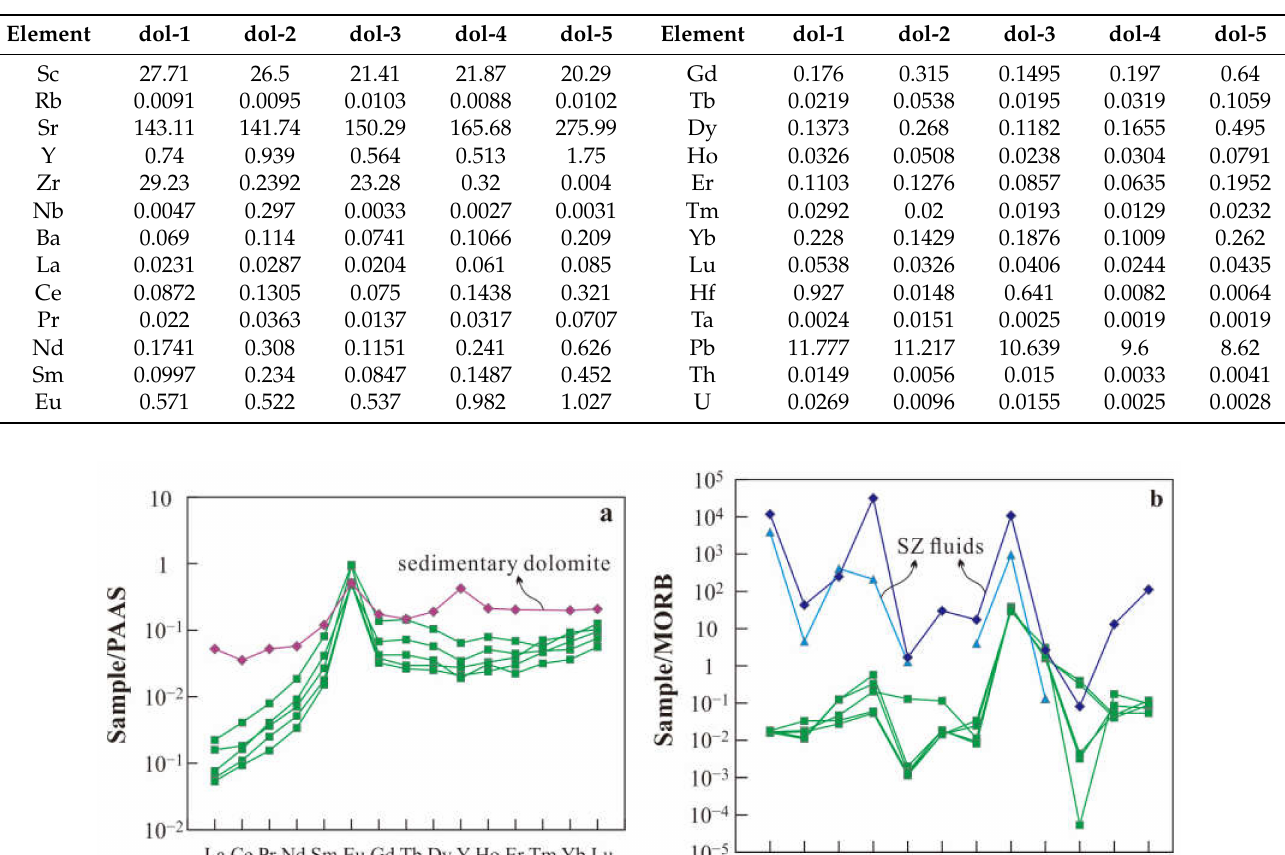
Table 1. Trace elements concentrations (ppm) of dolomite from the chlorite schist.